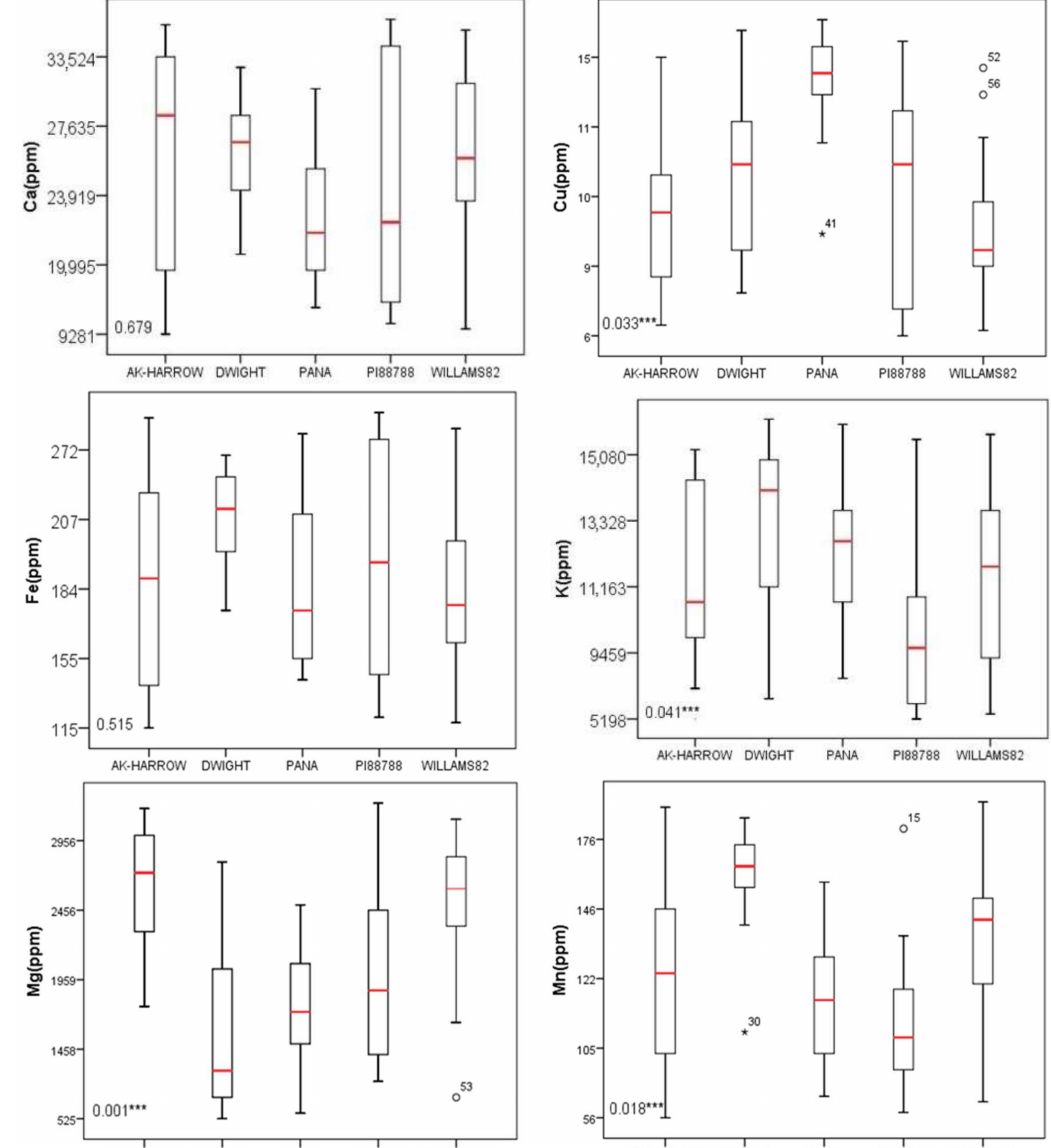
Figure 4. Variation in mineral nutrient concentration within soybean genotypes on 13 August 2014. Whiskers indicate the 5th and 95th percentiles. Solid lines inside the box represent the median; the colored areas represent the 25th and 75th percentiles. The significant level is also shown (*** p < 0.05). At this growth stage, Ca and Fe variations are less significantly different among soybean genotypes. When plants were exposed to significant ozone damage on 13 August 2014, the foliar concentrations of K and Mn were lower and the Fe, Mg concentrations were higher for ozone-sensitive genotypes AK-HARROW and PI88788 than for the rest of the